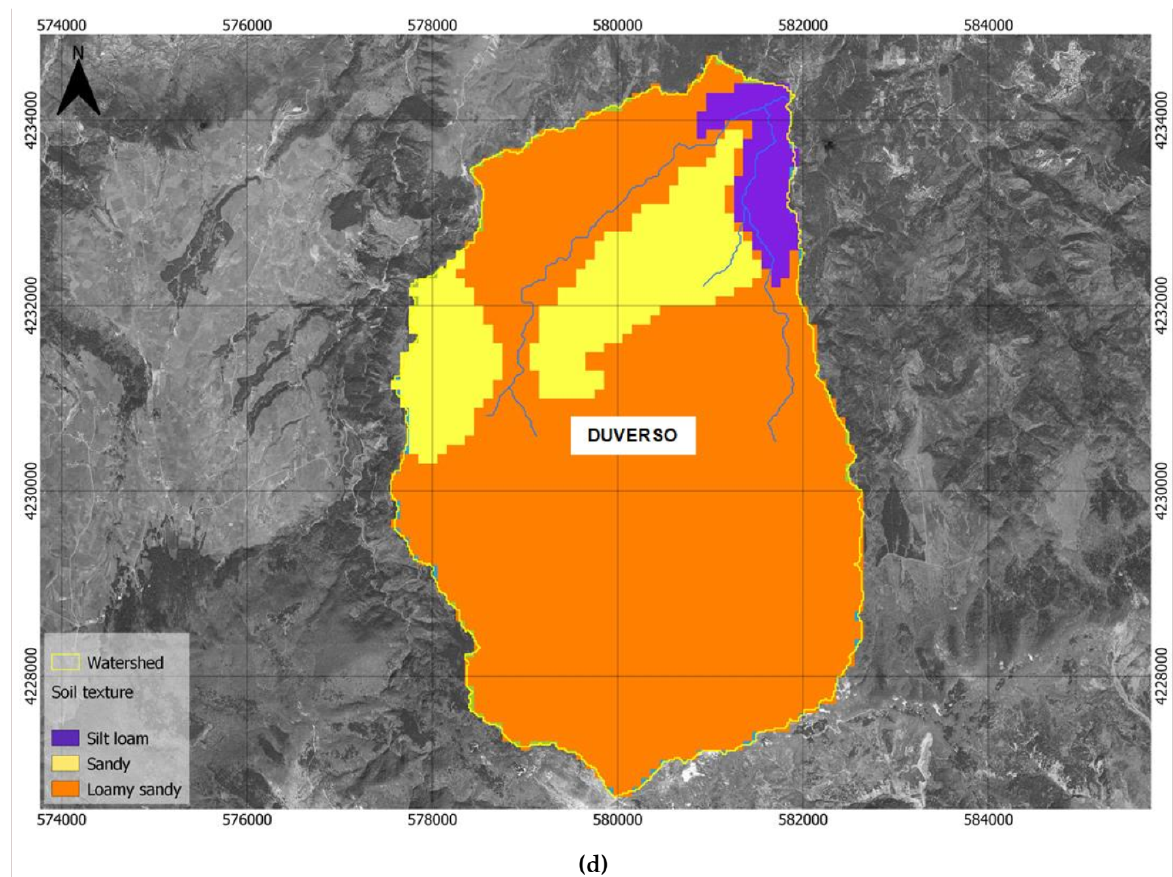
Figure 3. Land use ( a ) Serra and Vacale, ( b ) Duverso torrents, by photo-interpretation) and soil texture distribution, ( c ) Serra and Vacale, ( d ) Duverso torrents, from the map by ARSSA, 2003) of the investigated sub-catchments (Calabria, Southern